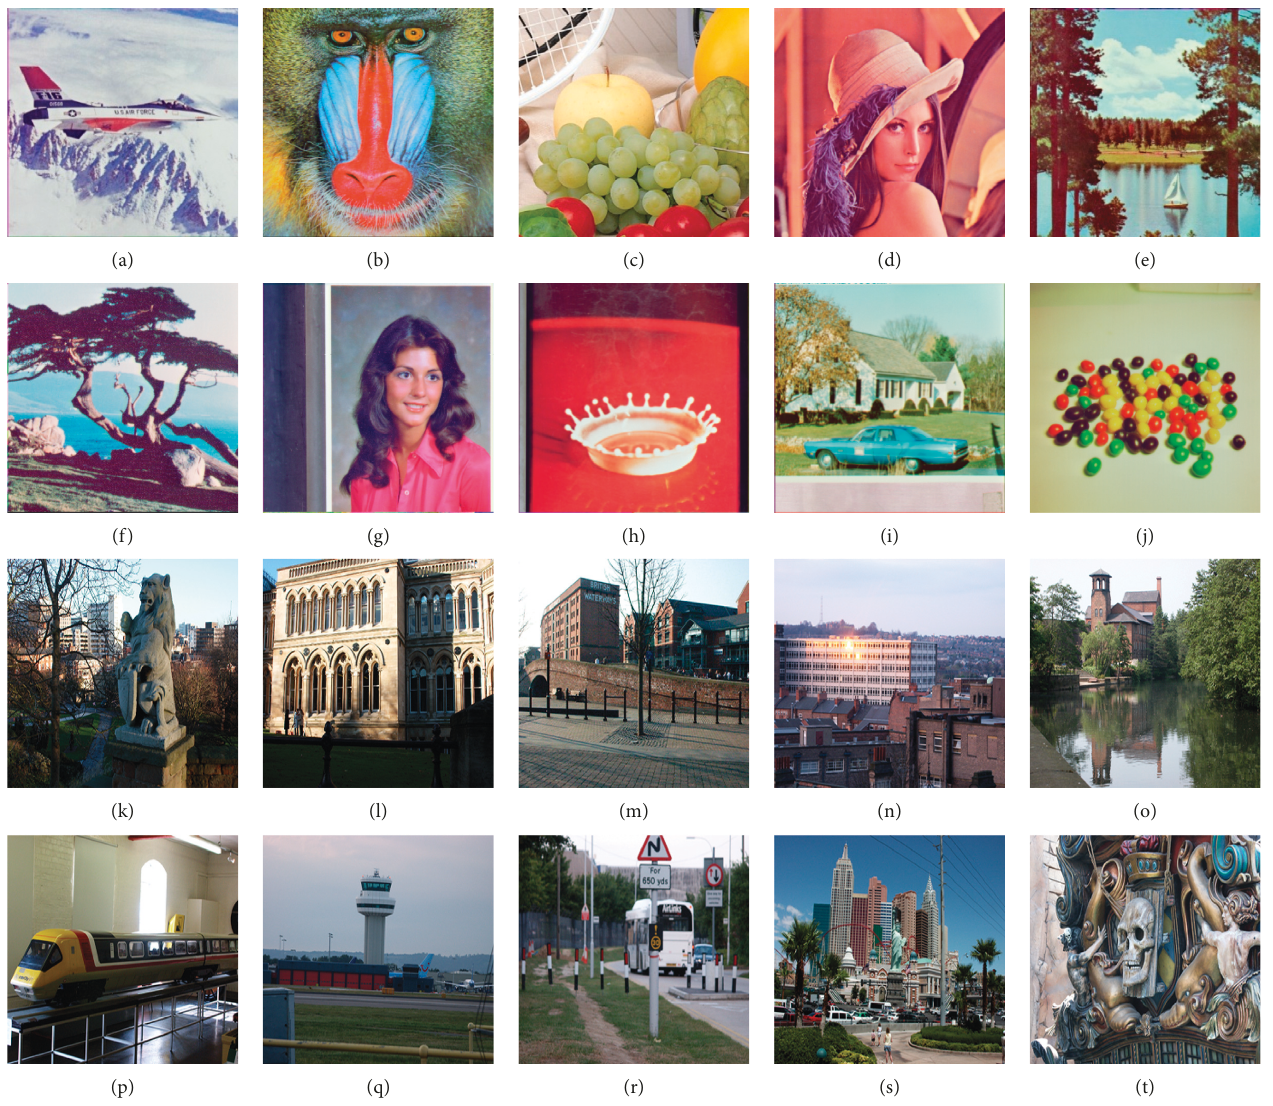
Figure 4: Image test set: (a) airplane; (b) baboon; (c) fruits; (d) Lena; (e) sailboat; (f) tree; (g) female; (h) splash; (i) house; (j) jelly beans; (k) ucid00010; (l) ucid00031; (m) ucid00182; (n) ucid00338; (o) ucid00463; (p) ucid00487; (q) ucid00586; (r) ucid00598; (s) ucid00779; (t)